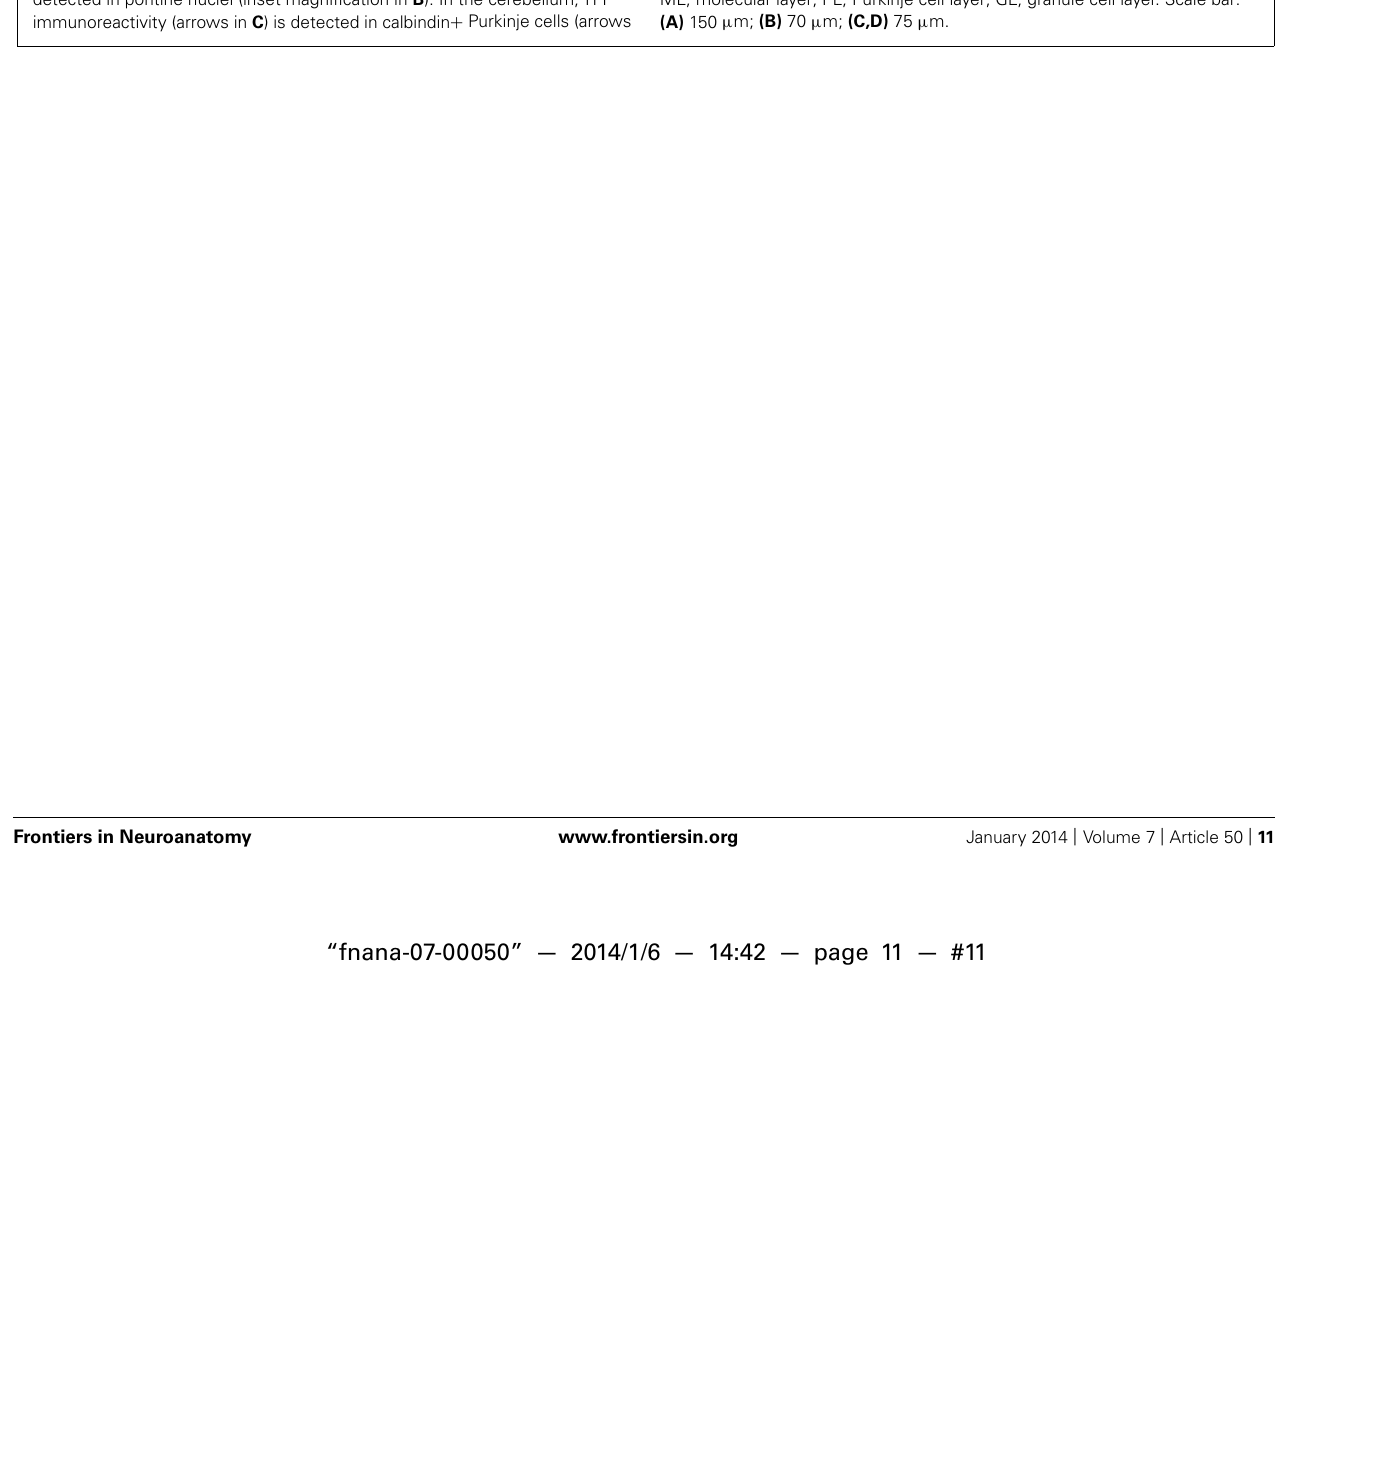
in C ). LargeYFP + cell bodies in the granule cell layer (arrow in D ) are NeuN negative, likely representing Golgi interneurons. CaBP, calbindin; ovl, overlay; ML, molecular layer; PL, Purkinje cell layer; GL, granule cell layer. Scale bar: (A) 150 μ m; (B) 70 μ m; (C,D) 75 μ